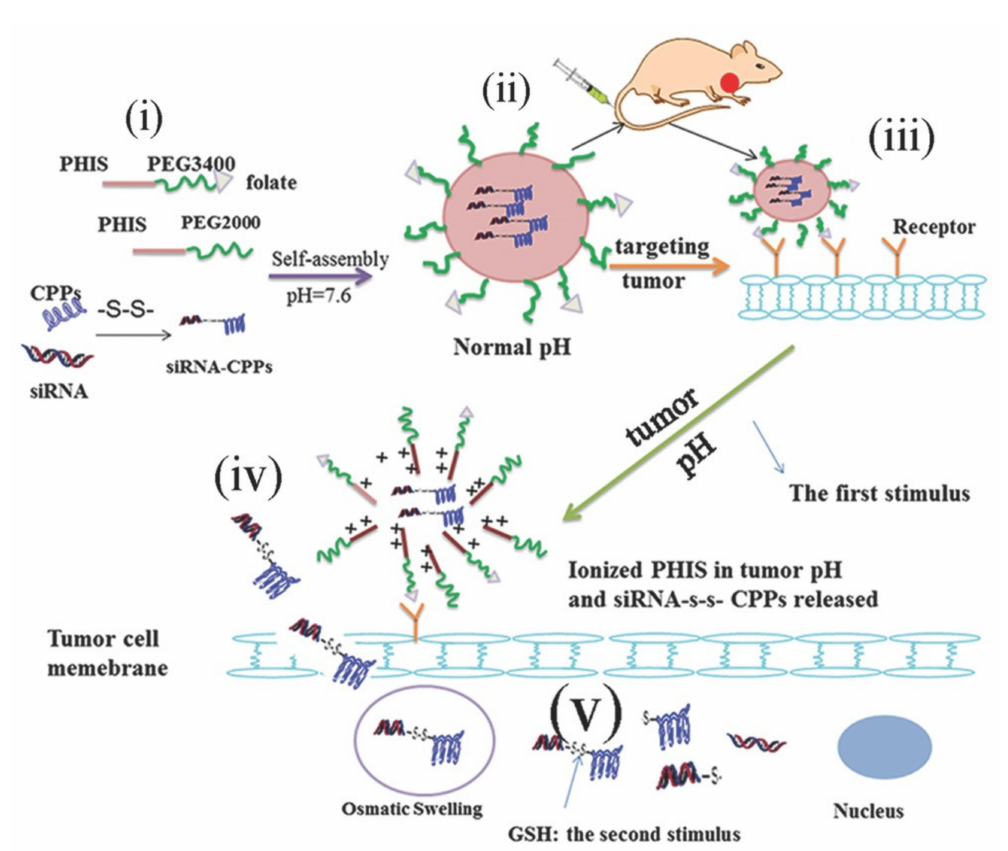
Figure 10. Diagram of F-ASPM formation and the mechanism of siRNA delivery into cancer cells. ( i ) synthesis of PEG-PHIS and F-PEG-PHIS. ( ii ) self-assembly of amphiphilic block copolymers in the presence of siRNA-CPP into acid-sensitive nanocarriers with active targeting ability (F-ASPM). ( iii ) binding of F-ASPM to cancer cells by folate receptor targeting. ( iv ) pH-stimulated release of siRNA-CPPs from F-ASPM. ( v ) GSH-mediated cleavage of disulfide bond of siRNA-CPPs leading to release free siRNA into cytosol. Reprinted with permission from [273]. Copyright 2016 John Wiley and